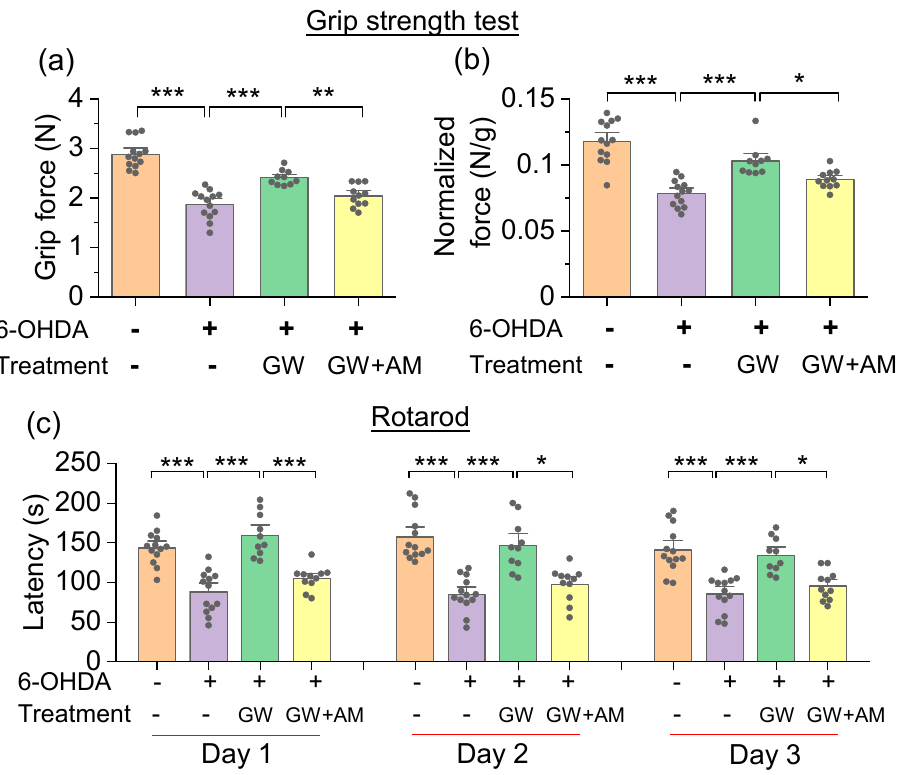
Figure 5. GW842166x (GW) treatment attenuated 6-OHDA-induced motor deficits in the grip strength test and rotarod test. ( a , b ) In the grip strength test, 6-OHDA injection decreased the absolute grip strength (grip force, *** p < 0.001, n = 13–13) and normalized grip strength (normalized force, *** p < 0.001, n = 13–13), both of which were ameliorated by GW treatment (*** p < 0.001, n = 10–13). Co-treatment with AM630 (AM) prevented the protective effects of GW (** p = 0.009, * p = 0.044, n = 10–11). ( c ) In the rotarod test, 6-OHDA injection significantly decreased the latency to fall (*** p < 0.001, n = 13–13), GW treatments significantly increased the latency to fall (*** p < 0.001, n = 10–13), and AM co-treatments prevented the effect of GW (* p < 0.05, *** p < 0.001, n =